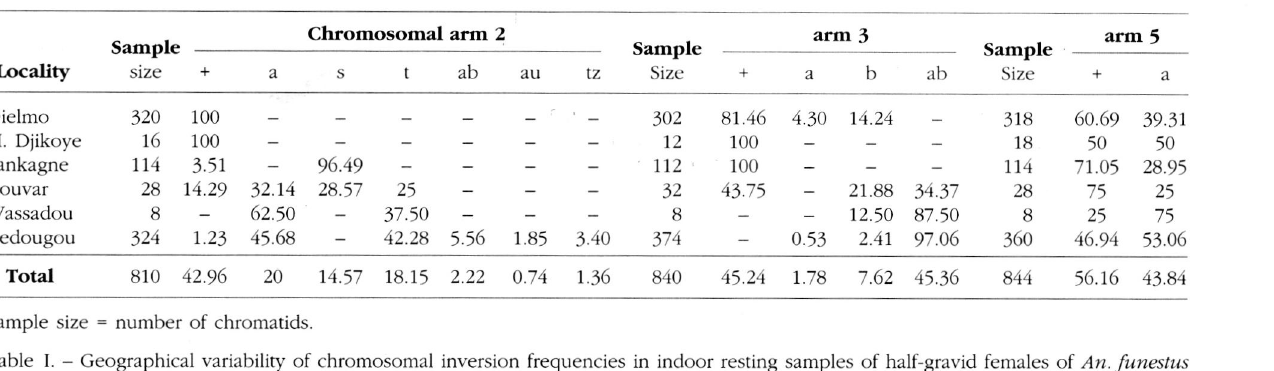
2s; the inversions 2a and 2t were predominant at fre quencies of 45.68 % and 42.28 %, respectively (Table I).